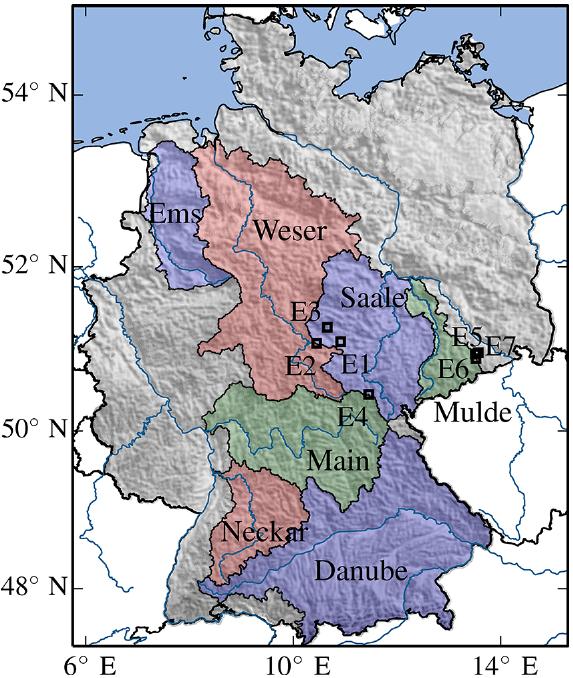
Figure 1. Study area showing the seven basins used for estimation of the ensemble parameter sets for Germany. The different colors are making the basins better distinguishable. The points E1–E7 de- note eddy covariance stations, which are used for the evaluation of evapotranspiration and soil